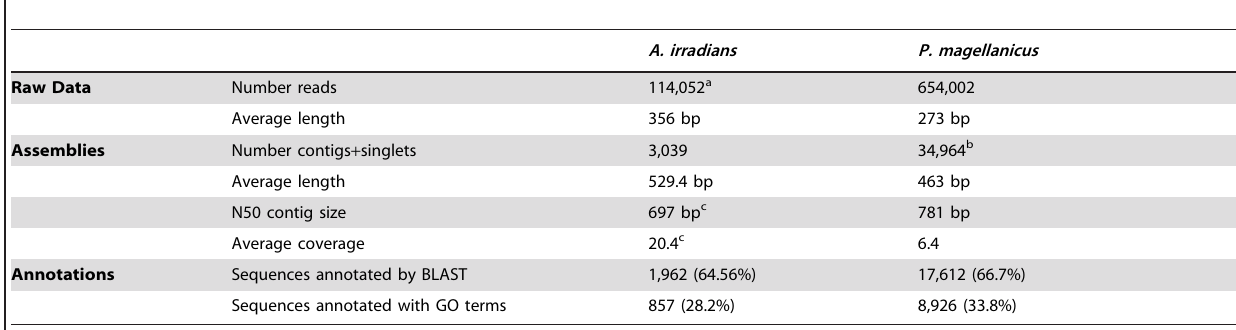
Table 1. Summary of A. irradians and P. magellanicus eye transcriptome sequence and assembly